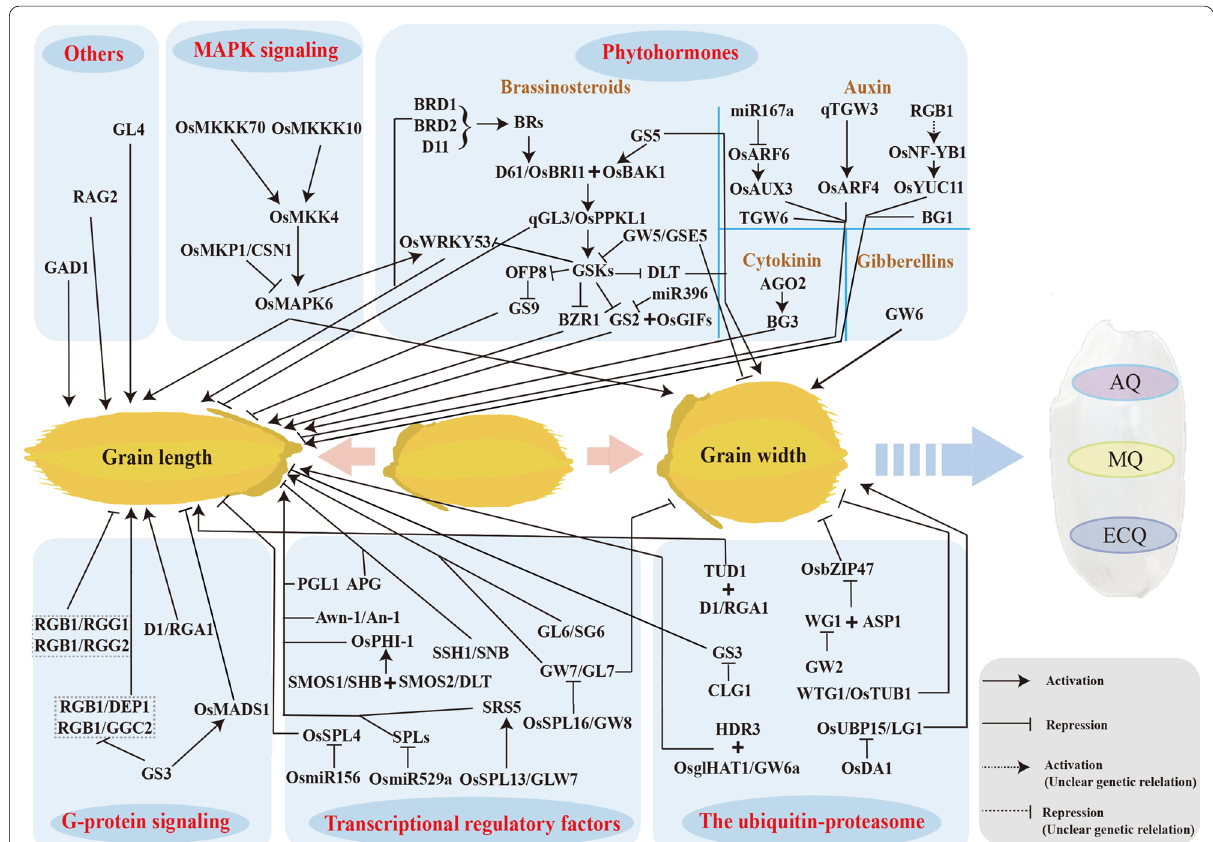
Fig. 3 The cloned genes and the major regulatory networks controlling rice size. Rice seed size is regulated by multiple signaling pathways, including G protein pathways, the ubiquitin–proteasome pathway, MAPK signaling pathways, phytohormones, and transcription regulatory factors. A dotted line indicates that the genetic relationship needs to be further verified. MAPK, Mitogen‑Activated Protein Kinase; AQ, appearance quality; MQ, milling quality; ECQ, eating and cooking